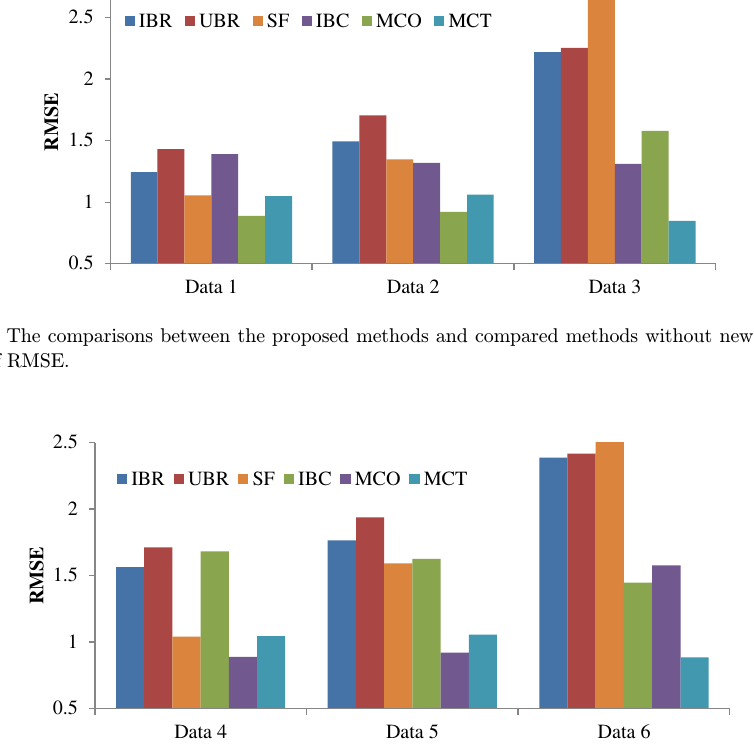
Fig. 6. The comparisons between the proposed methods and compared methods with new users in terms of